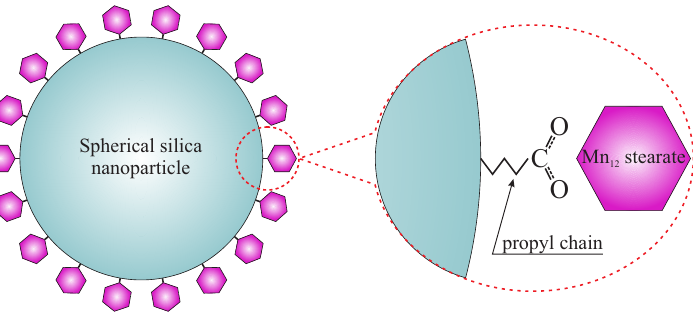
Figure 1. A schematic representation of the proposed